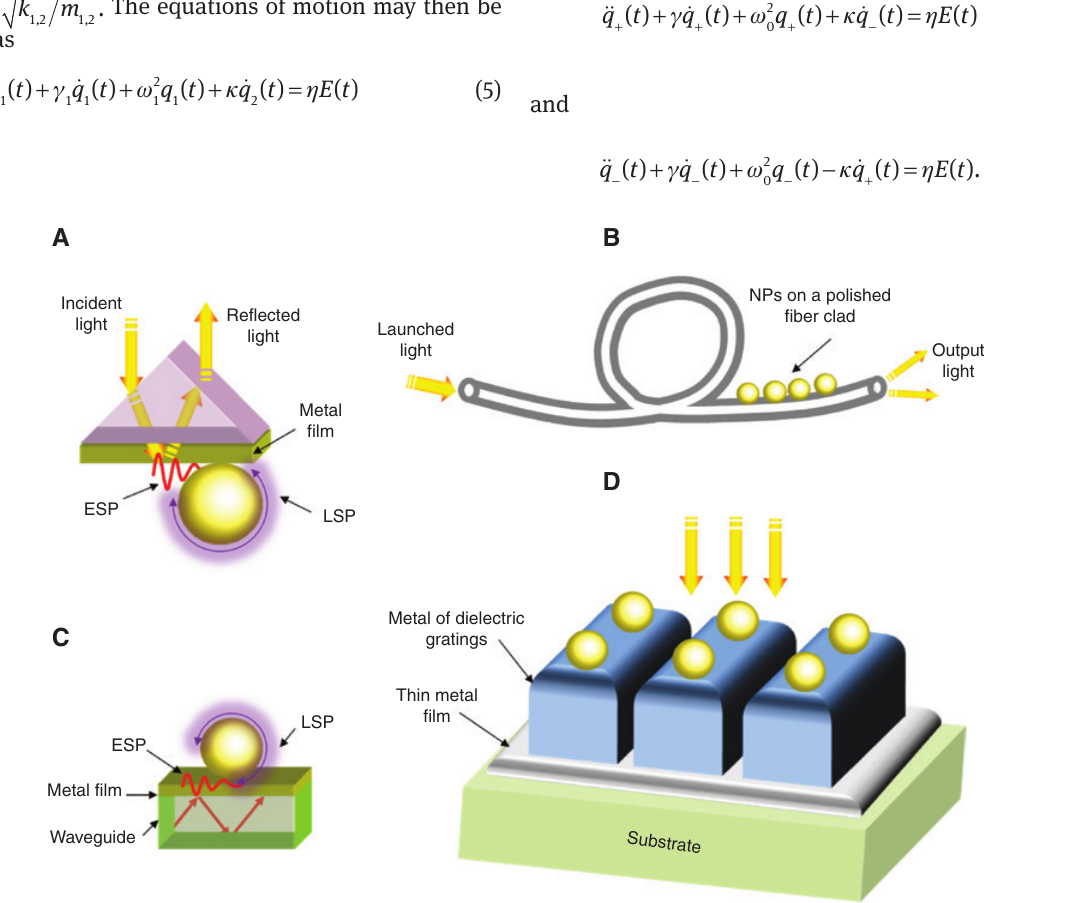
Figure 13: Several configurations for exciting LSPs via ESPs. (A) prism coupling, (B) fiber coupling, (C) waveguide coupling, and (D) grating